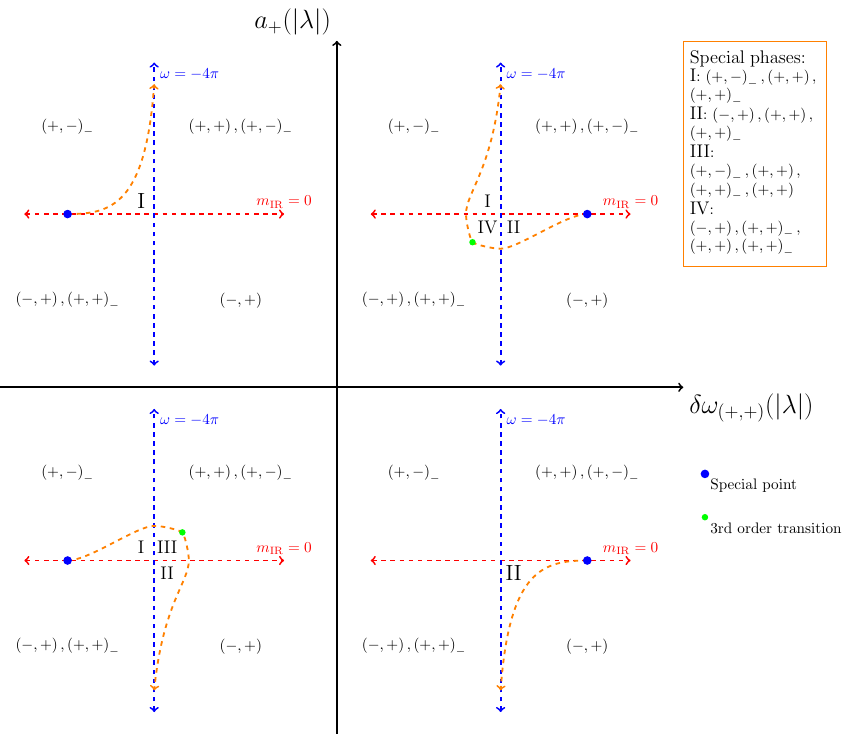
Figure 7. Possible changes to the (+ , +) “special phase” at large values of λ